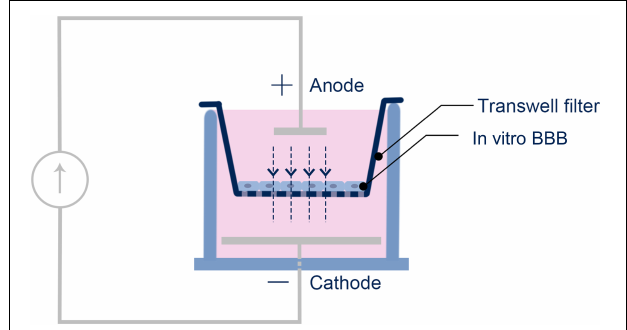
FIGURE 1 | Schematic of the setup for the DCS application to the in vitro BBB. The in vitro BBB was formed by hCMEC or bEnd3 monolayer on the Transwell